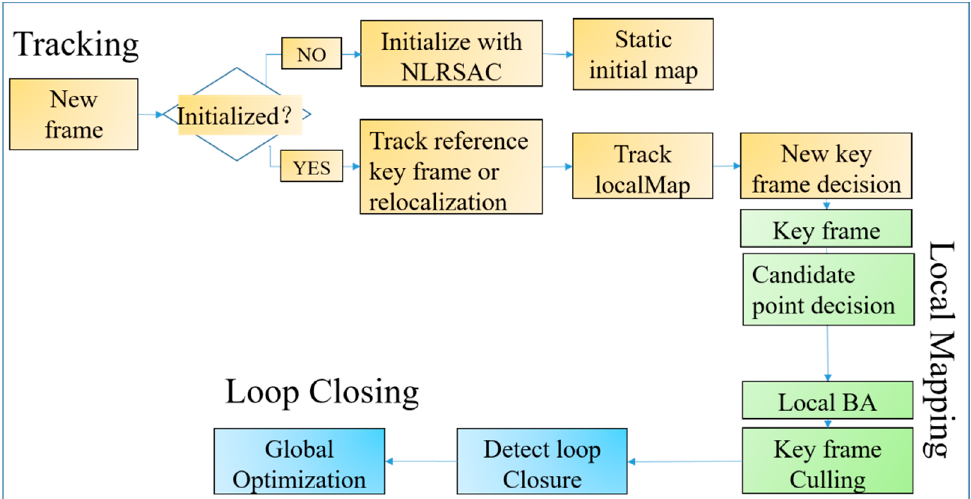
Figure 1. The framework of DM-SLAM. DM-SLAM share same loop closing thread with ORB-SLAM2. There are three process including tracking, local mapping and loop closing. Tracking is mainly responsible for extracting the initial pose of the camera utilizing the input images, where we integrate distribution and local-based RANSAC algorithm (DLRSAC) into the initialization in tracking process. Local mapping is responsible for saving, filtering and optimizing key frames and map points, where we integrate algorithms 1 into candidate point decision. The closed-loop detection mainly detects whether there is a closed-loop, and if so, global optimization is performed.